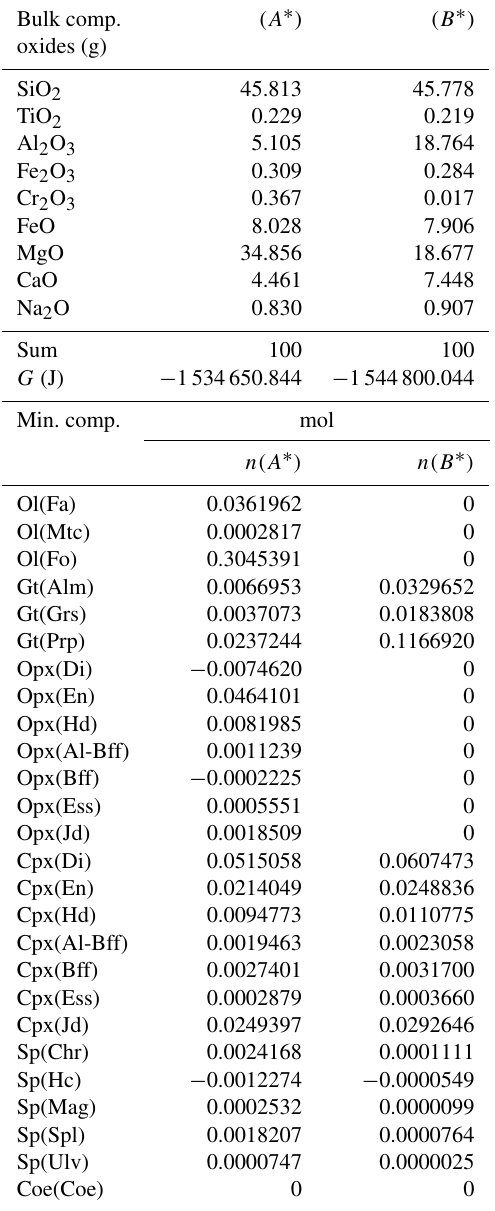
Table 7. Normalized bulk composition ( A ∗ ) and ( B ∗ ) of the two subsystems taken from the results of the model in Table 6. The lower part of the table shows the equilibrium mineral composition computed with the program AlphaMELTS for each subsystem sep- arately.